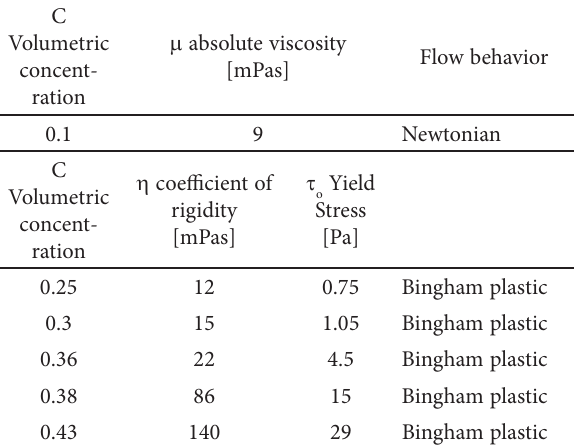
Table 8. Flow properties of Nikola Tesla B Power Plant – Serbia, Fly Ash: ( x